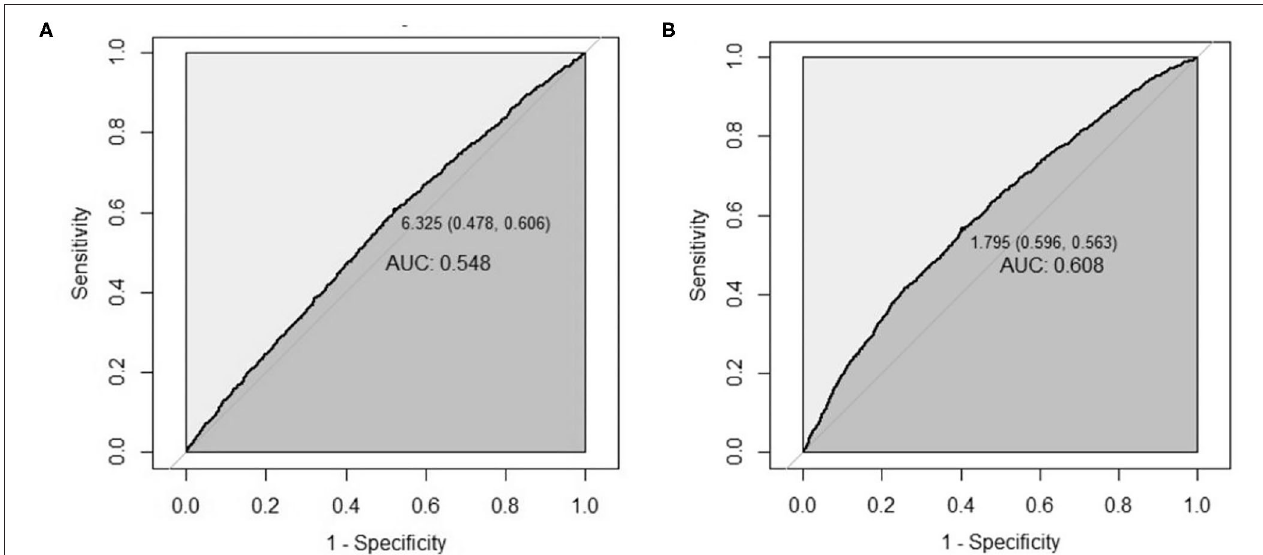
FIGURE 2 | The AUC of leukocyte count and hs-CRP for predicting platelet reactivity. (A,B) The AUC of leukocyte count for predicting LTPR (A) , and the AUC of hs-CRP for predicting HTPR (B) . AUC, area under curve; LTPR, low on-treatment platelet reactivity; HTPR, high on-treatment platelet reactivity.